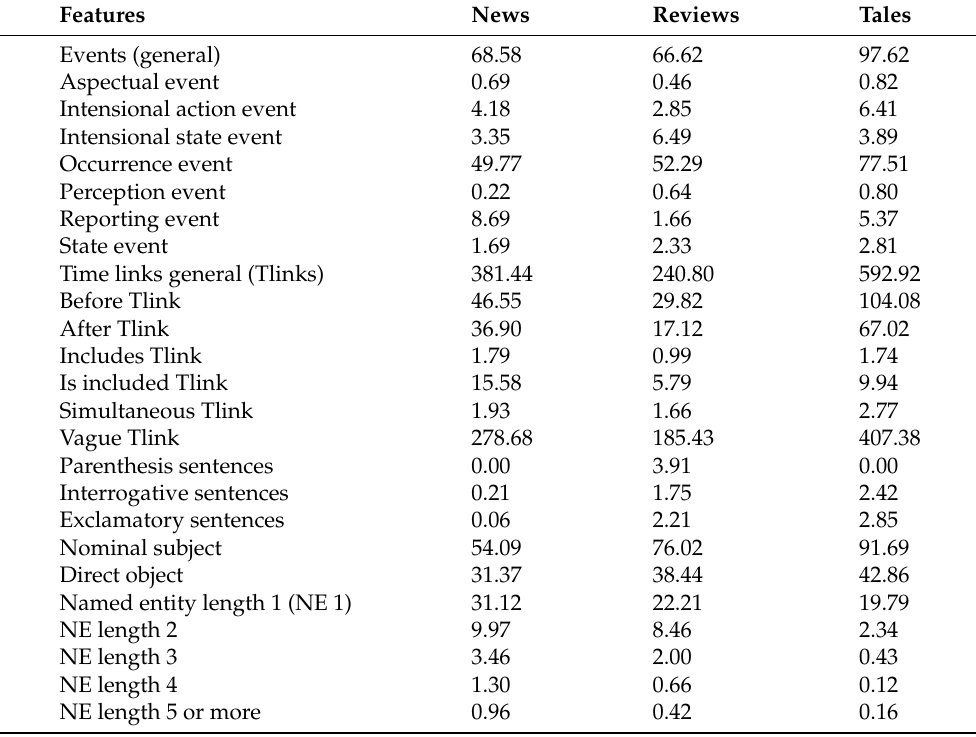
Table 4. Average semantic features per